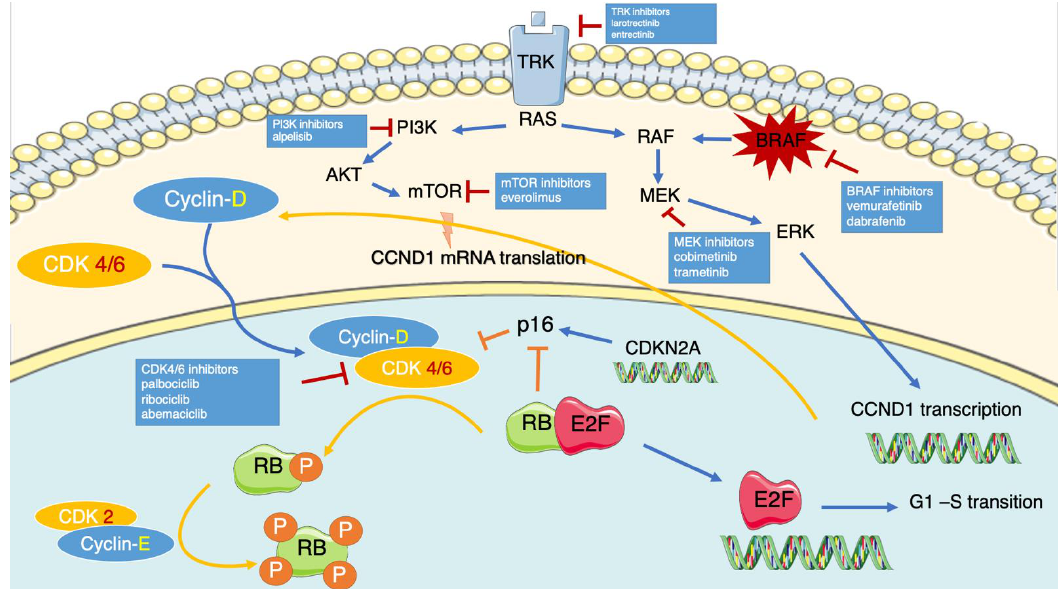
Figure 1. Graphic representation of the most relevant pathways, and their interconnection, that regulate the p16ink4A-cyclin D-CDK4/6-RB pathway. The stimulation of tyrosine kinase receptors on the cell membrane by mitogen stimuli activates the Ras axis, leading to the transcription of CCND1 gene with an increased expression of Cyclin-D. In parallel, the PI3K pathway (PI3K-Akt-mTor) regulates the downstream translation of CCND1 mRNA via mTor. In cellular cytosol, the Cyclin D1 forms complexes with its binding partners, CDK4/6, and translocates to the nucleus. Here, mutually with the downstream complex CyclinE-CDK2, it hyperphosphorylates the RB protein, thus inactivating it. Subsequently, E2F is released and drives the transcription of the genes involved in the G1-S transition. This pathway is negatively regulated by some natural inhibitors, such as p16INK4A, that inhibit the assembly of the Cyclin D-CDK4/6 complex. Moreover, p16INK4A is usually suppressed by the hypophosphorylated form of RB. The CDK4/6 mediated-hyperphosphorylation of RB causes its inactivation and relieves the RB1-mediated suppression of p16INK4A.